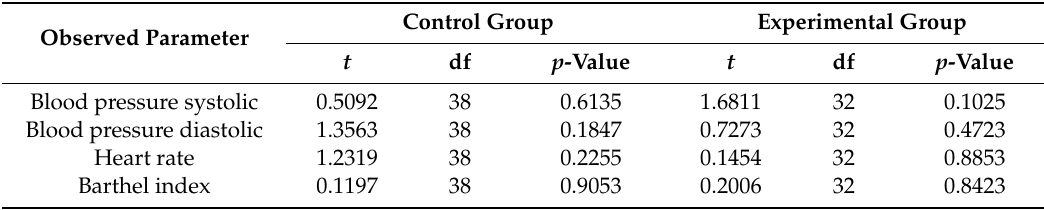
Table 2. Results of di ff erentiation testing in groups before and after therapy (paired-samples t -tests were used for dependent selections).